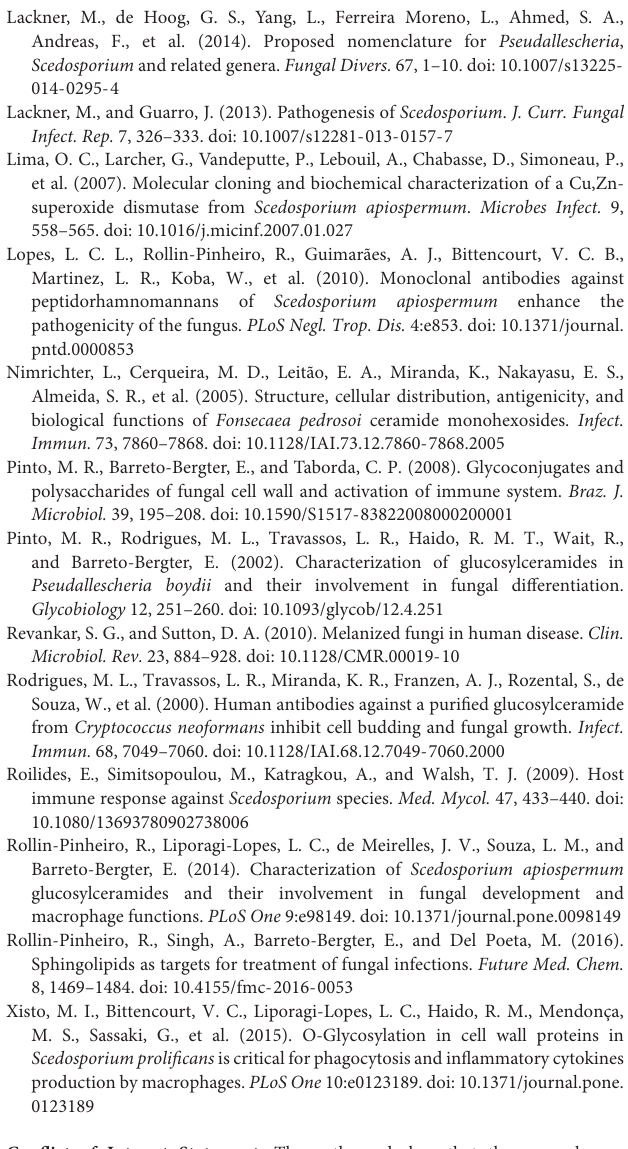
10 colors was designed to distinguished some types of cell: CD4 T, CD8 T, B cells, neutrophils, eosinophils, large peritoneal macrophage (LPM), small peritoneal macrophage (SPM), CD11c+CD11b+MHCII+ and CD11c+ CD11b-MHC+. All the gates were sat up based on the FMO